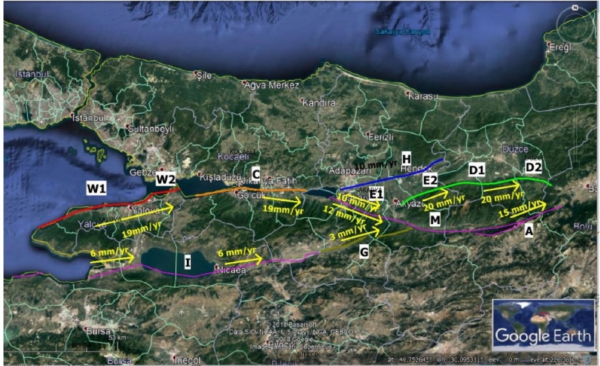
Figure 3. Source model of [11] for eastern Marmara region.